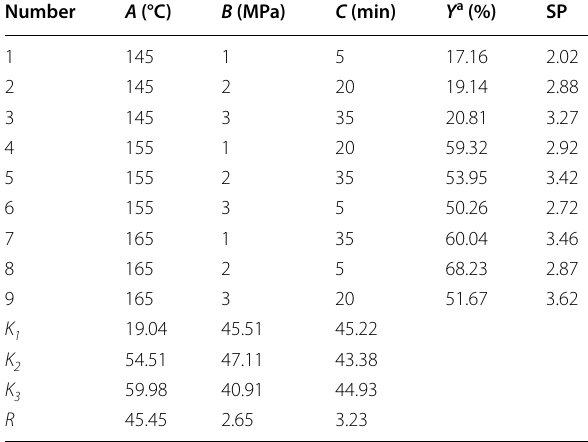
SP: severity parameter a Y is the XOS (X 2 − X 5 )